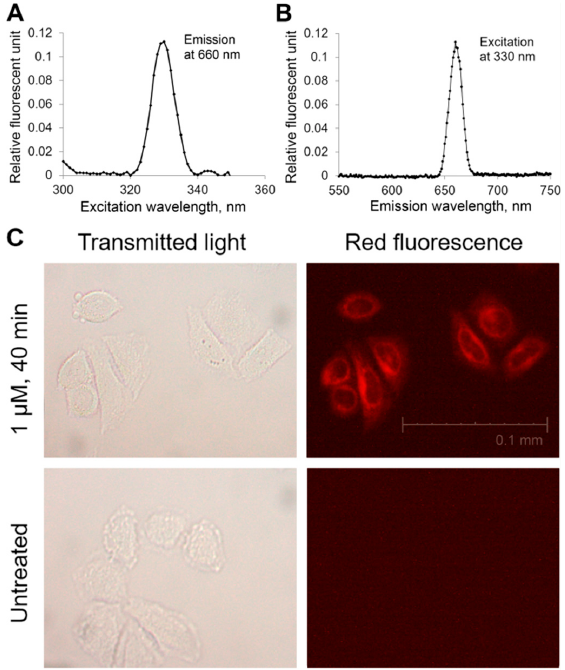
Figure 5. Spectrum of fluorescence excitation ( A ) and emission ( B ) of 0.5 μ M Compound 21 solution. Light micrographs ( C , left column) and fluorescent micrographs ( C , right column) of cells after 40 min treatment with Compound 21 ( C , upper row) and without it ( C , lower row). Magnification: 600×.